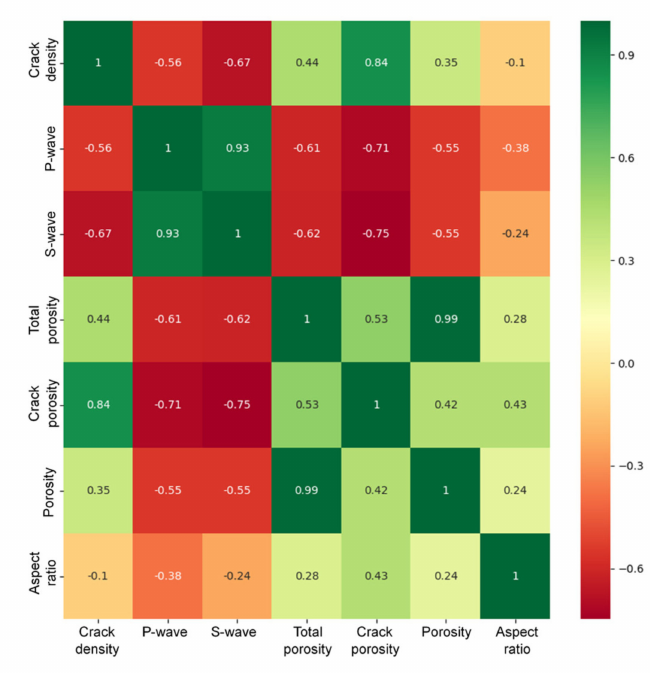
Figure 12. GRG results among variables.